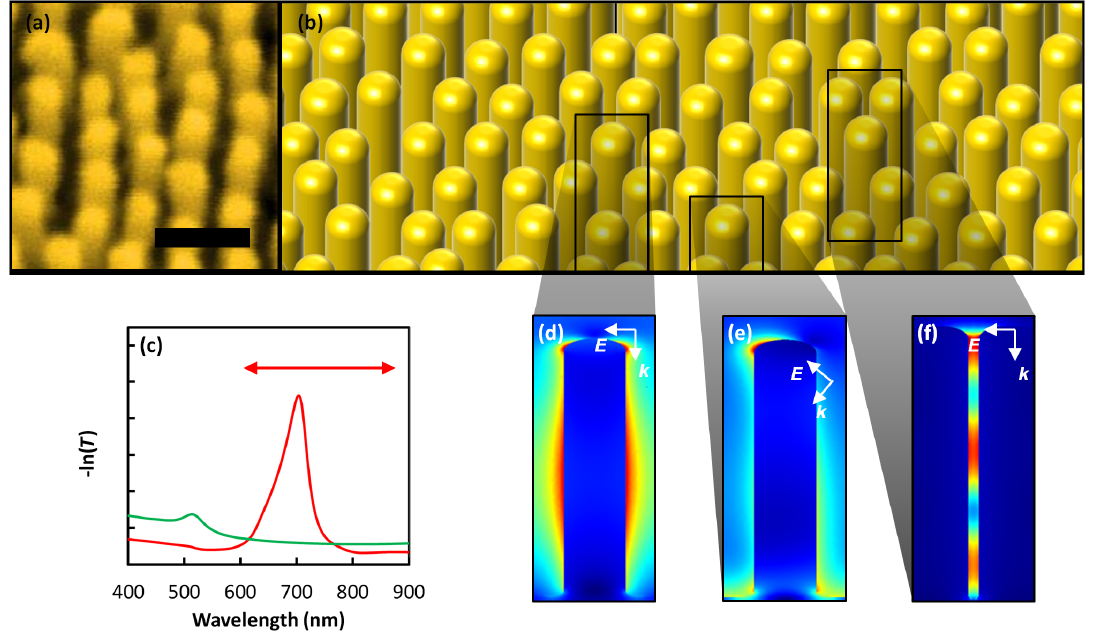
FIG. 1. Scanning electron microscope (SEM) image and schematic illustration of a quasiordered freestanding nanorod array, along with typical optical-extinction spectra [ (cid:1) ln ð T Þ ] and near-field profiles on excitation of LSPRs. (a) SEM image taken at 40 (cid:2) from normal of Au nanorods (scale bar ¼ 100 nm ) and (b) matching schematic illustration. (c) Modeled extinction spectra of nanorod arrays in air: The green spectrum is for normal incidence excitation, showing the transverse LSPR of the nanorods. The red spectrum is for 40 (cid:2) -incidence excitation by p -polarized light and illustrates the longitudinal LPSR for 450-nm-long nanorods. The red arrow indicates the range of tunability of the longitudinal LSPR. Plots of the modeled electromagnetic field in the near field of nanorods illustrate the excitation of the (d) transverse-, (e) longitudinal-, and (f) cavity-mode LSPRs. In (d) and (e), the inter-rod gap is 40 nm, while in (f) it is 4 nm. In (d)–(f), the array period is 65 nm and the nanorods are 200 nm long. E and k as marked indicate the polarization and wave vector of the incident radiation,